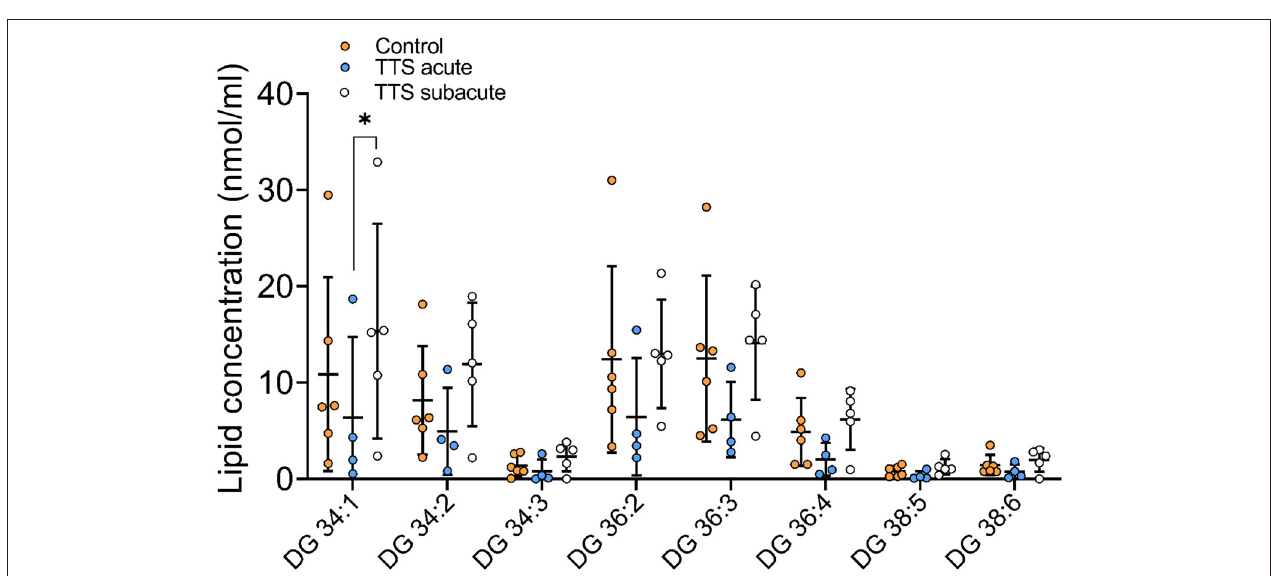
FIGURE 8 | Composition of individual DG lipid species in the acute TTS, subacute TTS, and control groups. Values are represented as nmol/ml. Values are mean ± SD, P -value: * P < 0.05. Where significance is not mentioned, values are considered as being not significant. DG, Diacylglycerol; TTS, Takotsubo syndrome.